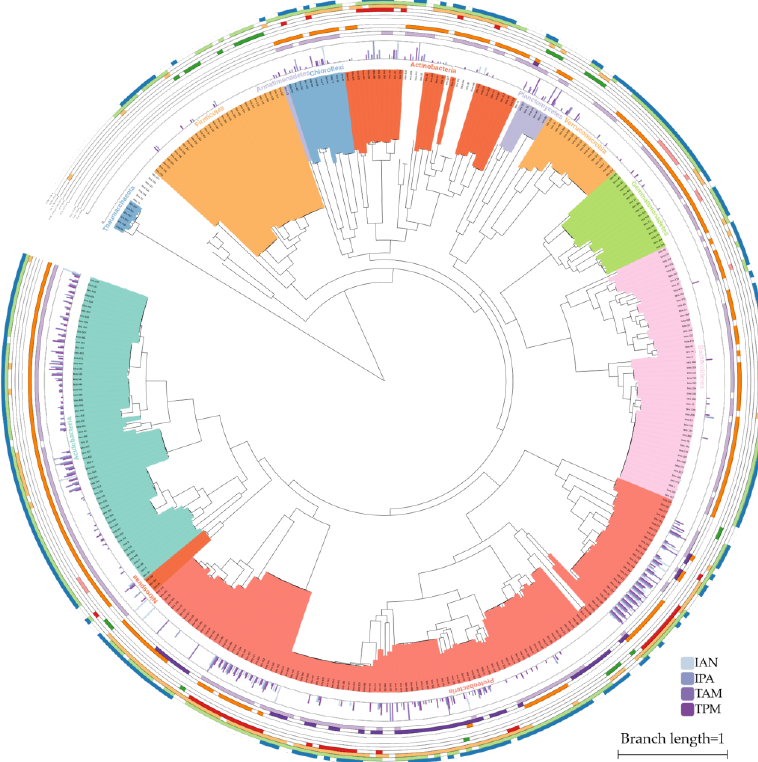
Figure 4. The phylogeny and distribution of IAA synthesis pathways in rhizobacteria. The tips of the tree are masked with different colors to indicate corresponding phylum. The histograms represent the percent of genes in each pathway located on plasmids. The three inner rings and six outside rings show the distribution of different Trp-catalyzing enzymes and capacities for synthesizing IAA from intermediates by different pathways, respectively. The blank space along the rings represent that no related genes or pathways are found in the